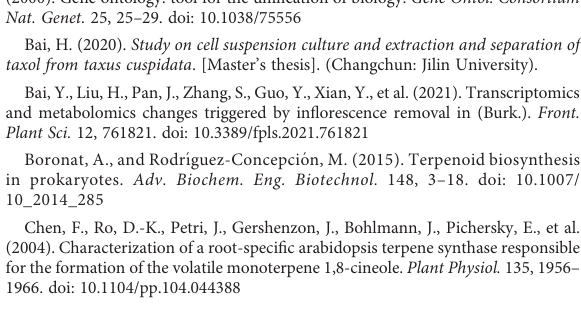
SUPPLEMENTARY FIGURE 1 Annotation results of six databases through UpSetR. SUPPLEMENTARY FIGURE 2 The GO enrichment directed acyclic graph. SUPPLEMENTARY FIGURE 3 The DEGs enriched in the lysine biosynthesis pathway. SUPPLEMENTARY FIGURE 4 The DEGs enriched in the phenylalanine, tyrosine and tryptophan biosynthesis pathway. SUPPLEMENTARY FIGURE 5 The DEGs enriched in the phenylalanine metabolic pathway. SUPPLEMENTARY FIGURE 6 qRT-PCR con fi rmation of DEGs. SUPPLEMENTARY FIGURE 7 Growth curve of callus suspension culture. SUPPLEMENTARY FIGURE 8 Expression level of homologous sequences involved terpenoid biosynthesis pathway. SUPPLEMENTARY TABLE 3 DEGs of KEGG pathway enrichment